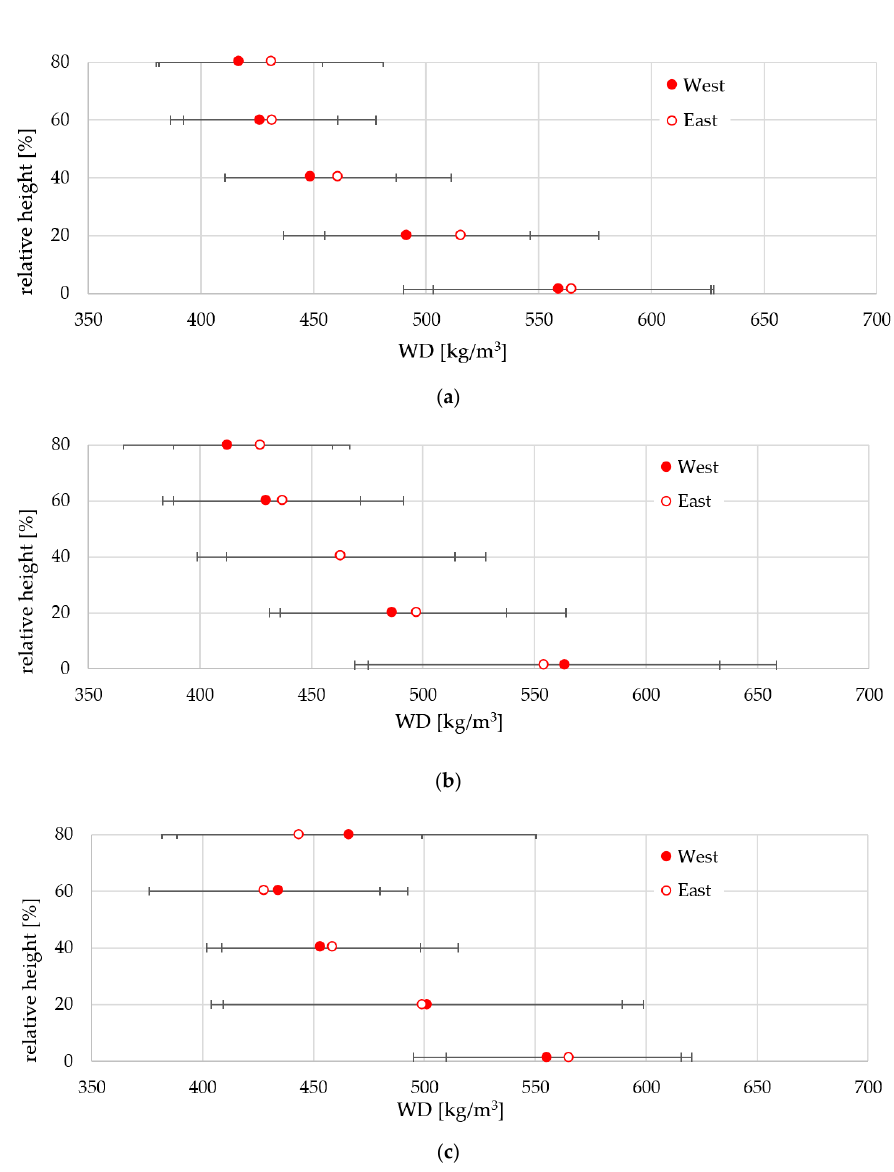
Figure 4. Variability in oven-dry density (WD) along the stem (the lines represented ± standard deviation): ( a ) plot A (0–20 m); ( b ) plot B (30–50 m); ( c ) plot C (60–80 m).